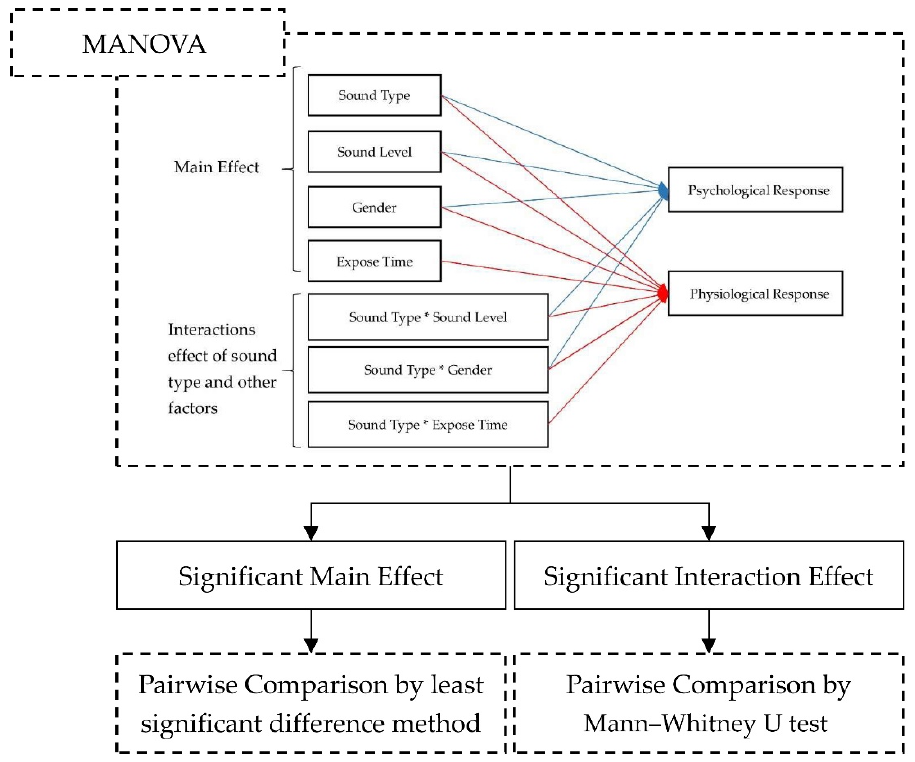
Figure 4. A flowchart of statistical analysis used in this study.